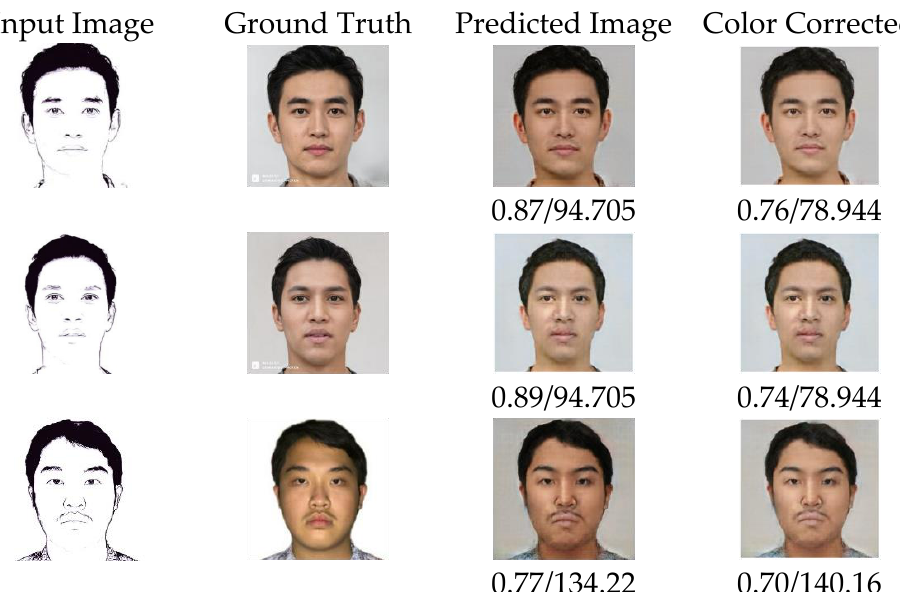
Figure 6. Results of pale white configuration in correcting the color of predicted images. The values below the images represent SSIM/FID. The ground truth images are from generated photos [17] and volunteers (private collection).